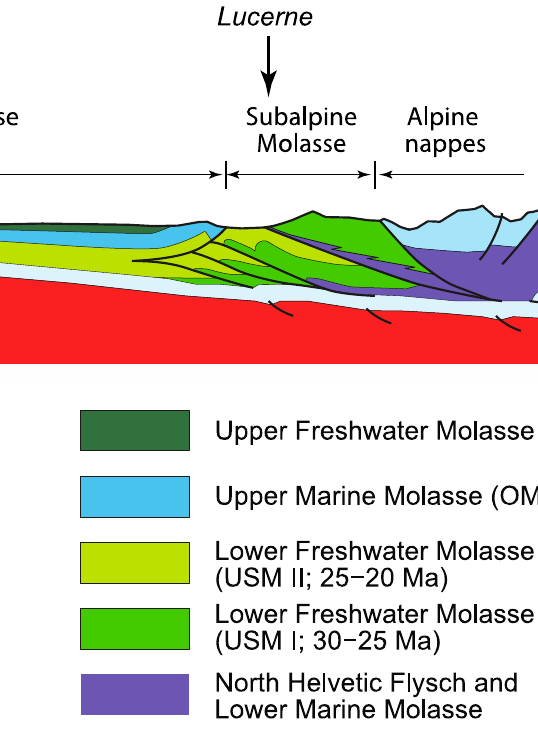
Figure 5. Tectonic section across the Swiss Molasse basin. Modified after [70,71]. The section starts in the Aar massif, crosses Lucerne and ends in the Jura fold-and-thrust belt in the North. This section runs parallel to that illustrated in Figure 3, but c. 20 km farther east. Please see Figure 2 for location of Lucerne, the Jura Mountains and the Aar massif.